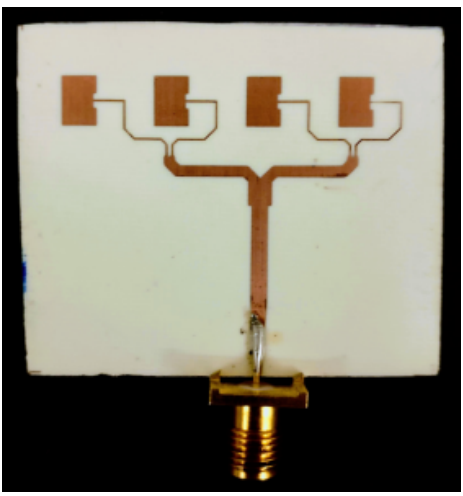
Figure 4. High gain antenna used on previous validation tests [5]. For each test, an element was placed between the antenna pair to be scanned. The maximum scanning area was 20 cm by 20 cm, due to physical limitations of the robotic arm. The maximum resolution of the manipulator was 3 mm, which limited the scan step to this value. So, at every scan step, the VNA measured the intensity of the signal transmitted by the emitter antenna on the receiver antenna. Initially, the antennas were placed at a distance of 20 cm, being later positioned at a distance of 9 cm. Figure 5 shows the setup of the antennas without the robotic manipulator used to test sensibility to different water thickness. The antennas installed in the robotic manipulator mounted on top of a robotic platform are represented in Figure 6.